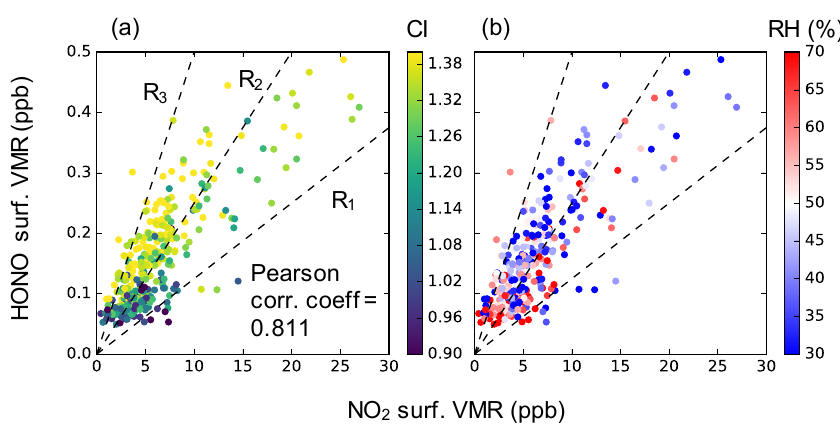
Figure 10. Scatter plots of (a) HONO ground concentration vs. NO 2 ground concentration coloured by colour index (CI), showing depen- dence of high HONO values on solar radiation. Note that CI is the ratio of intensities measured by the MAX-DOAS instrument at 330 and 390nm. The cloud-filtered CI correlated strongly with global irradiance measured 6km to the west at Melbourne Airport. (b) HONO ground concentration vs. NO 2 ground concentration coloured by relative humidity. Dashed lines represent the ratios R 1 HONO / NO 2 = 0.0125, R 2 HONO / NO 2 = 0.025 and R 3 HONO / NO 2 =